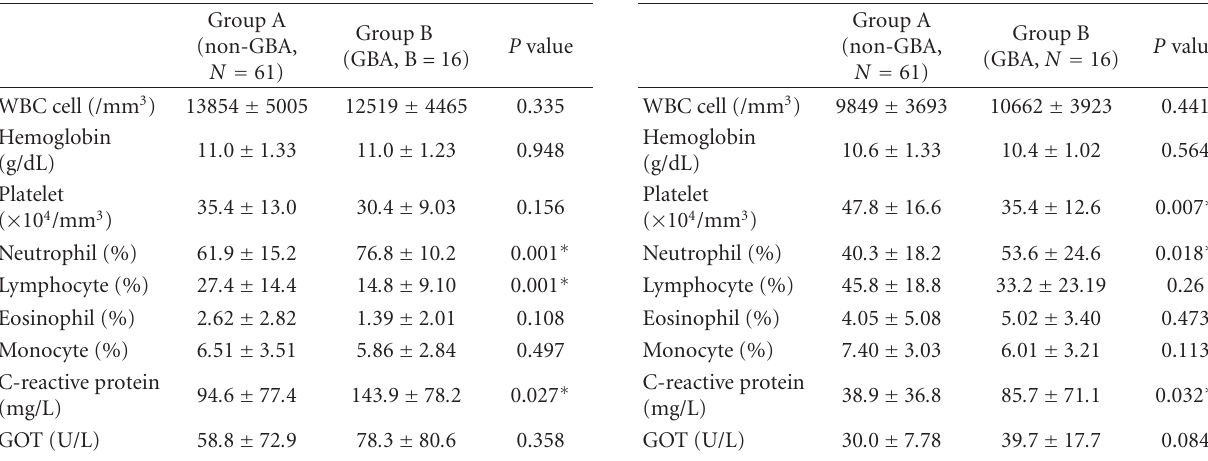
NS: nonsignificance.